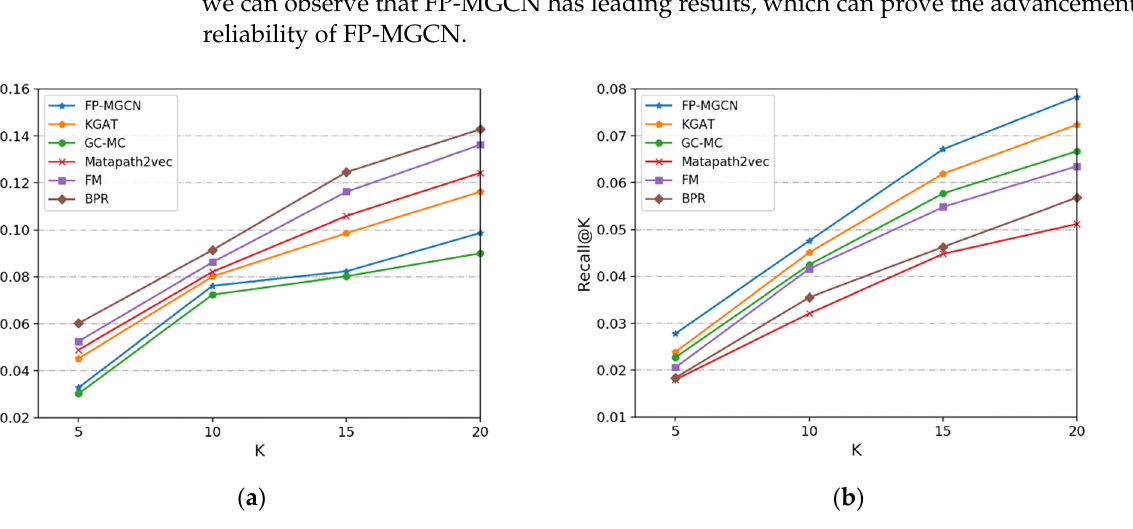
Figure 4. The results of NDCG@K on two datasets. ( a ) NDCG@K on Dianping; ( b ) NDCG@K on Yelp. 5.5. Study of FP-MGCN (RQ2) To further explore the embedding propagation framework of FP-MGCN, we analyze its impact from different perspectives. The effects of depth and different aggregators on each part are explored separately. 5.5.1. Effect of Model Depth We explore the best performance by varying the stacking of layers in the FP-MGCN model. The exploration for depth reflects the effect of the number of different aggregation iterations on the model performance. Specifically, we vary the number of propagation layers L in [1–5], and the results are shown in Table 3; through analysis, we can conclude that: •